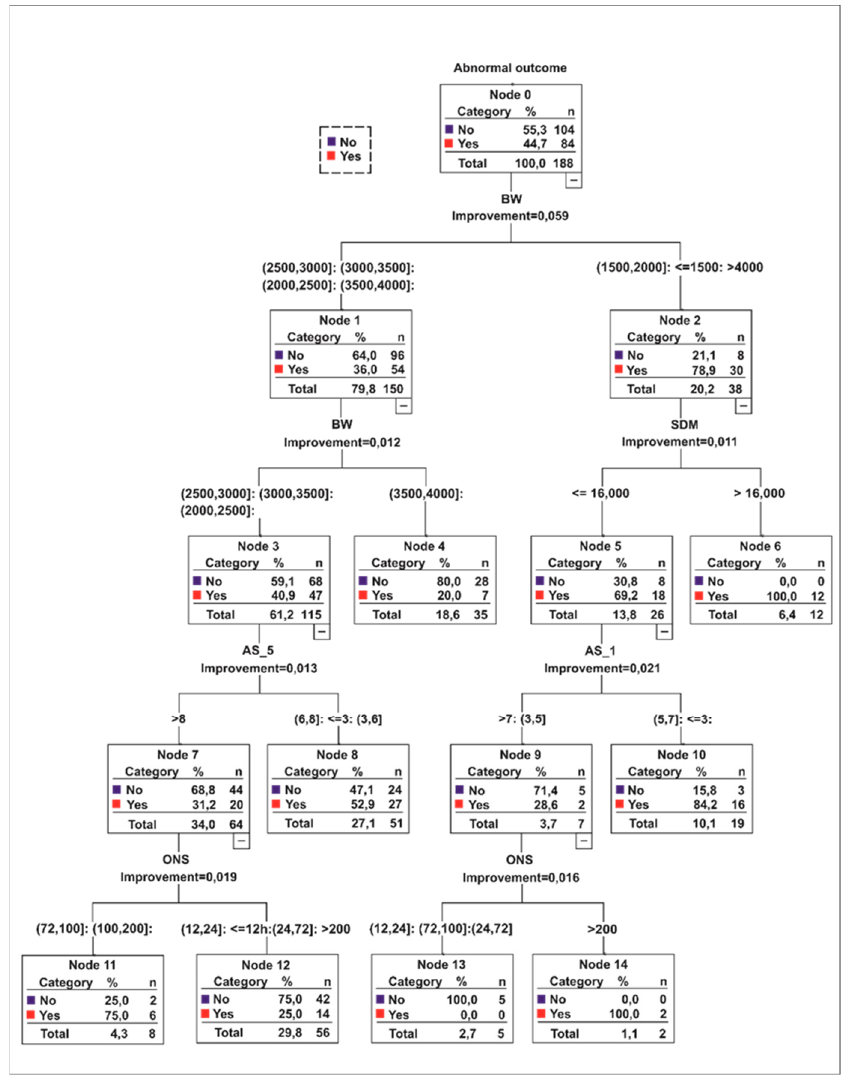
Figure 1. CART output illustrates a four-level decision tree (1–4). The cases partition is based on BW, AS1, AS5, ONS, SDM as prognostic factors related to abnormal outcomes (yes/no). The minimal change selection in impurity was 0.0001, whereas 5/3 were elected as minimal values for parent/child node. The hierarchy consisted of BW at level 1 and 2, SDM at level 2, AS1 and AS 5 at level 3, ONS at level 4.